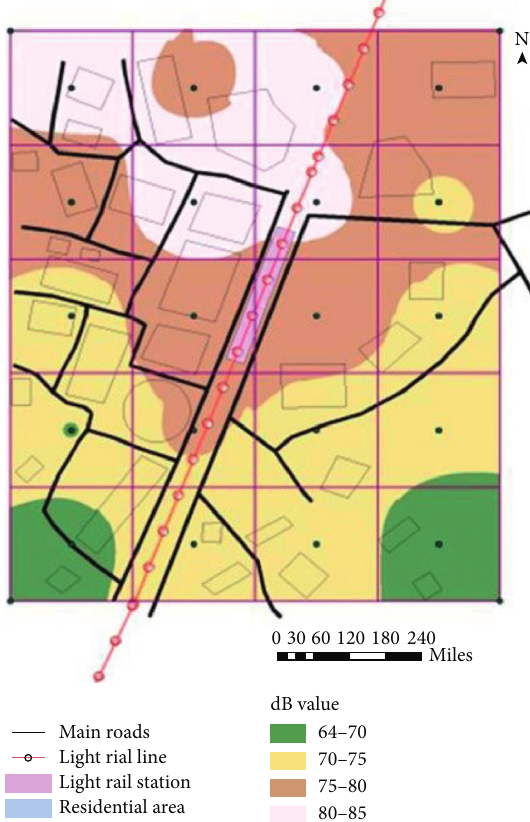
Figure 14: Acoustic environment map for the daytime.